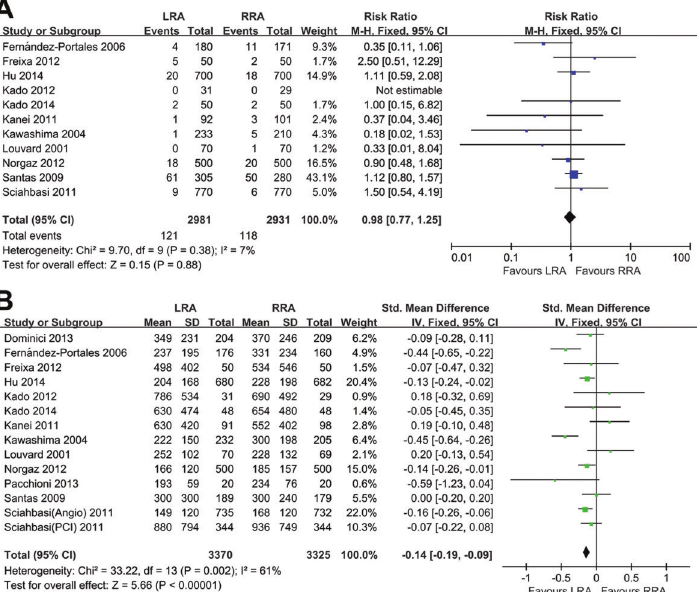
Figure 2. Meta-analyses of primary outcomes. A , Comparison of the left radial approach (LRA) versus the right radial approach (RRA) for procedural failure. B , Comparison of the LRA versus the RRA for fl uoroscopy time. In the study of Sciahbasi (13), we reported the meta-analysis results of percutaneous coronary intervention (PCI) and diagnostic angiography (Angio).